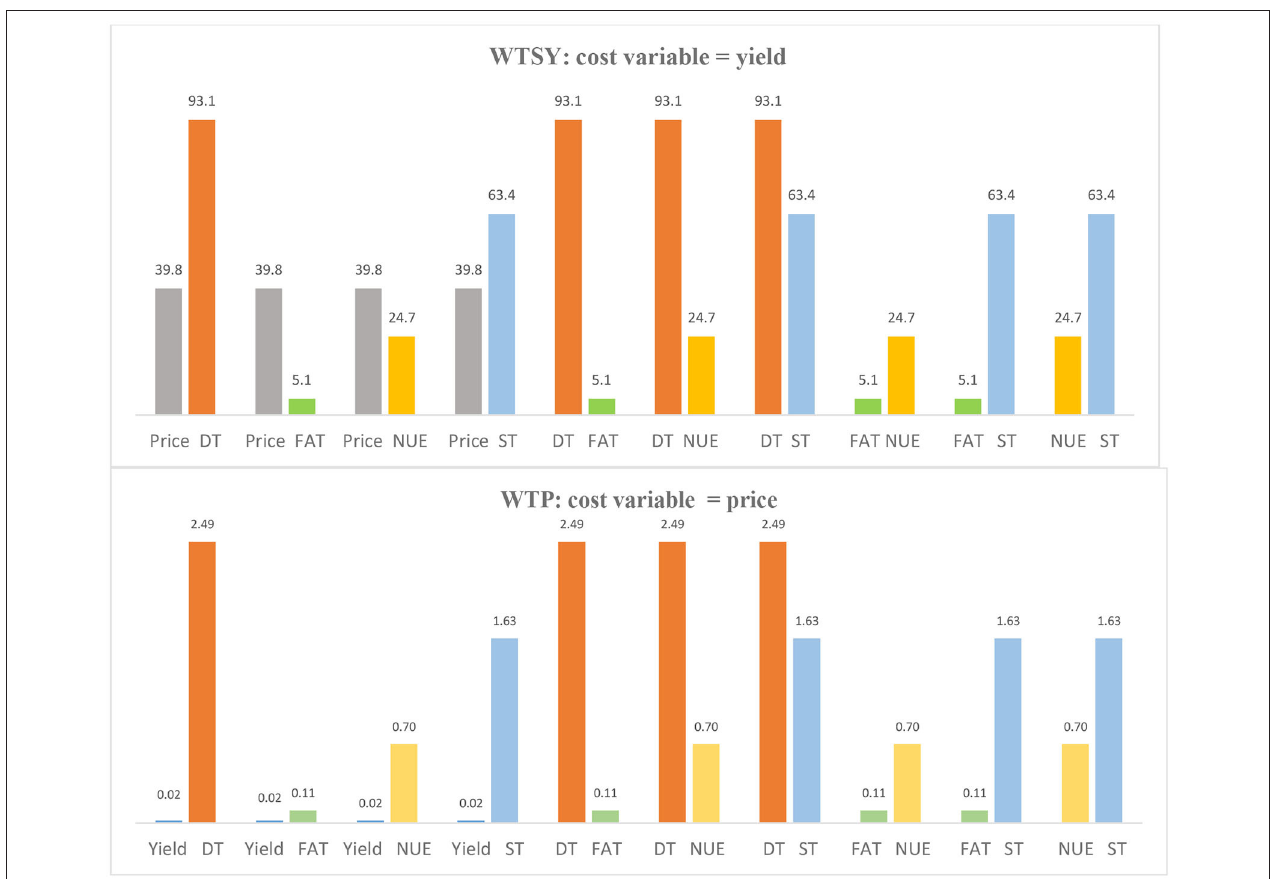
FIGURE 3 | Pairwise comparisons of WTP and WTSY between